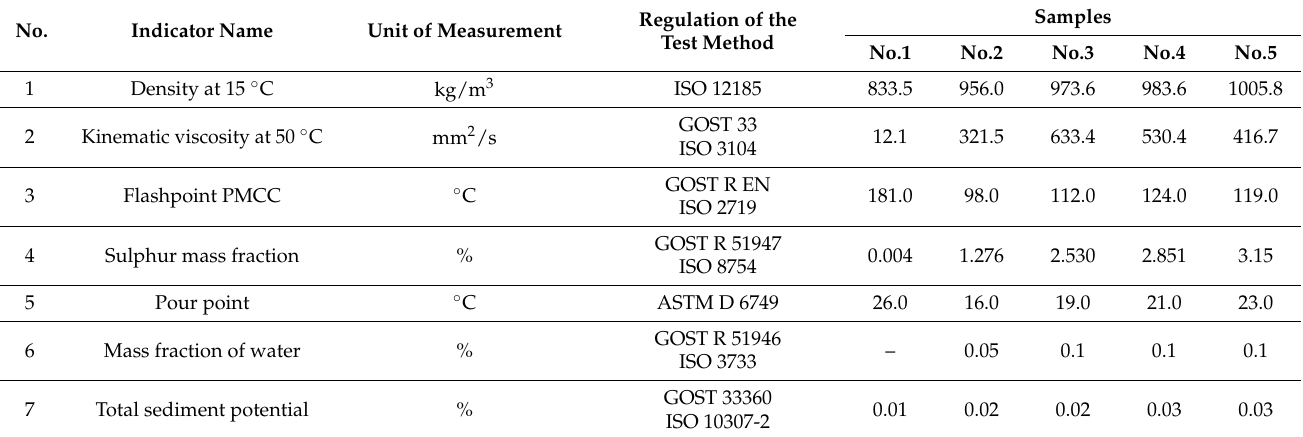
Table 1. Quality indicators of residual fuels.